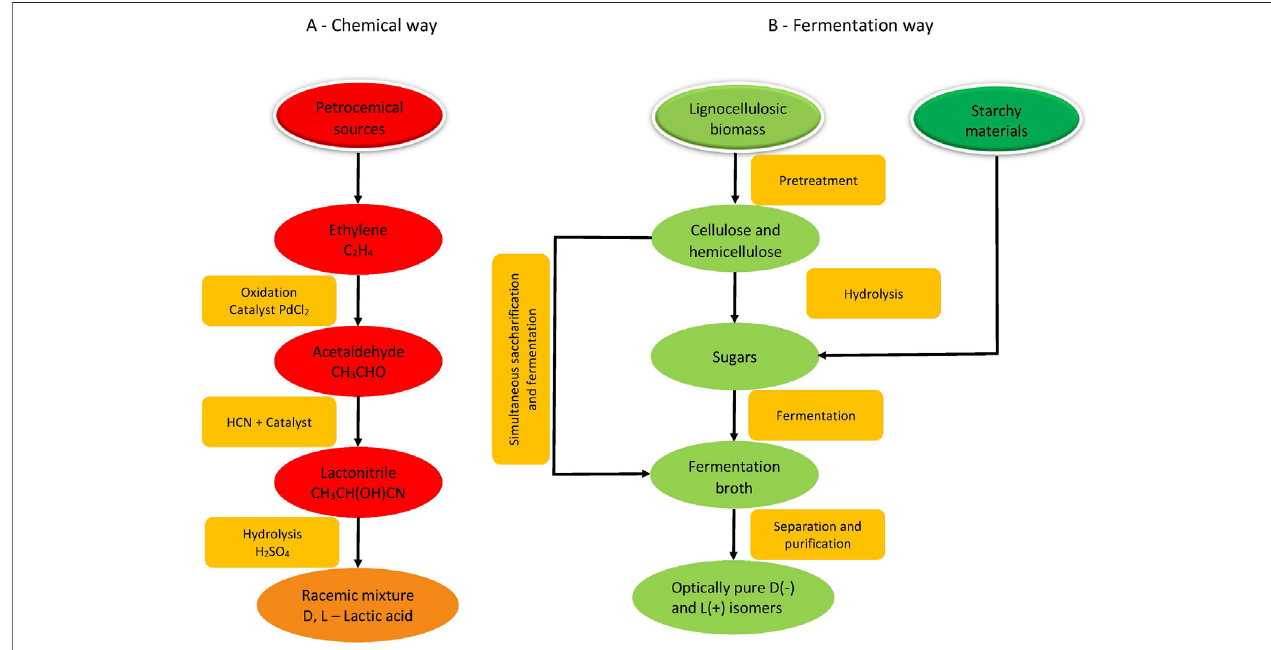
FIGURE 2 | Methods for lactic acid production (A-Chemical way; B — Fermentation